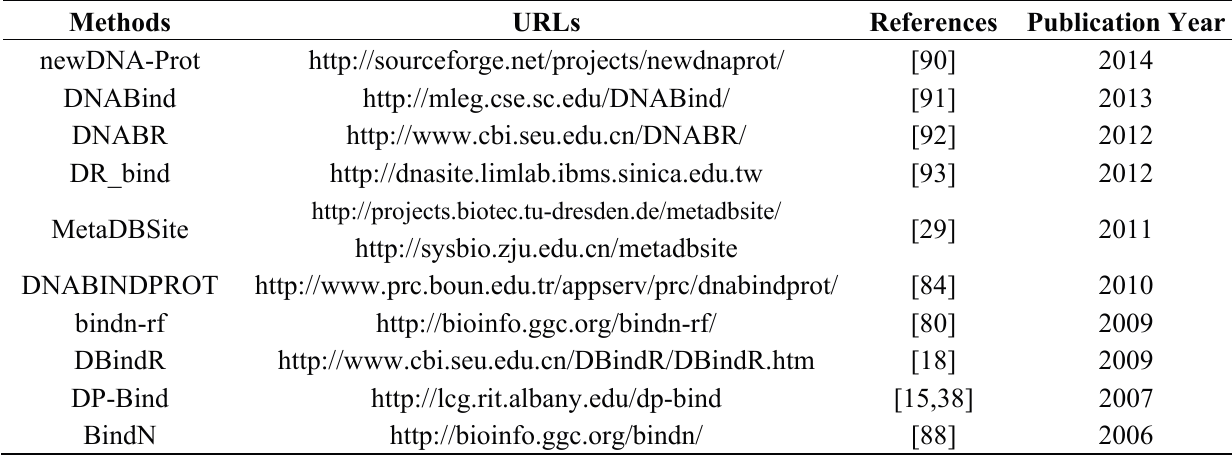
Table 4. A selection of DNA-binding protein or residues prediction Web